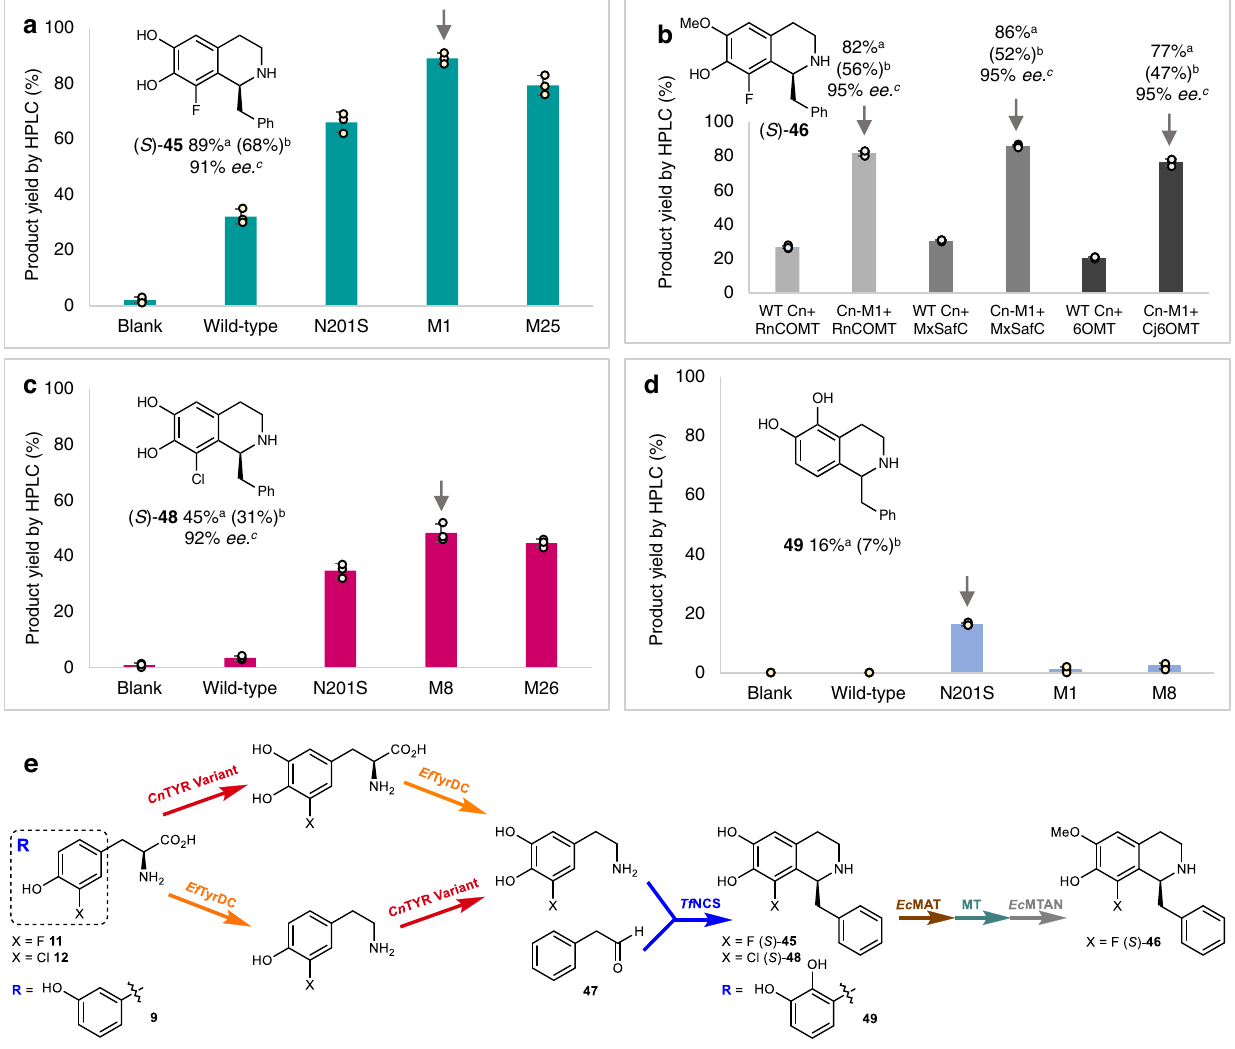
Fig. 6 | Production of alkaloids ( S )-45,46,48 and 49 using Cn TYR variants. a Production of ( S )- 45 using WT- Cn TYR, variants N201S, M1 (N201S/G205R/V206I) and M25 (N201S/G205R). b Production of ( S )- 46 using WT- Cn TYR and M1 (N201S/ G205R/V206I)togetherwithMTs Rn COMT/ Mx SafC/ Cj 6OMT, Ec MAT(SAMsupply), and Ec MTAN (SAH degradation). c Production of ( S )- 47 using WT- Cn TYR,